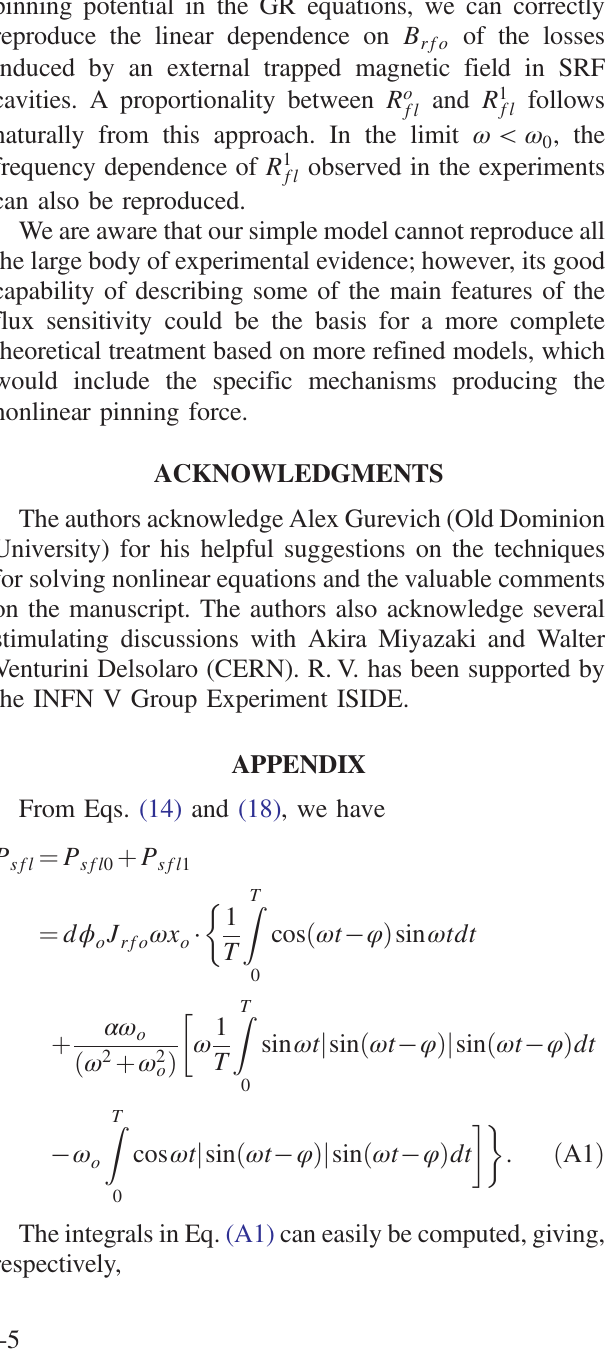
and R 1 for Nb = Cu films at fl fl